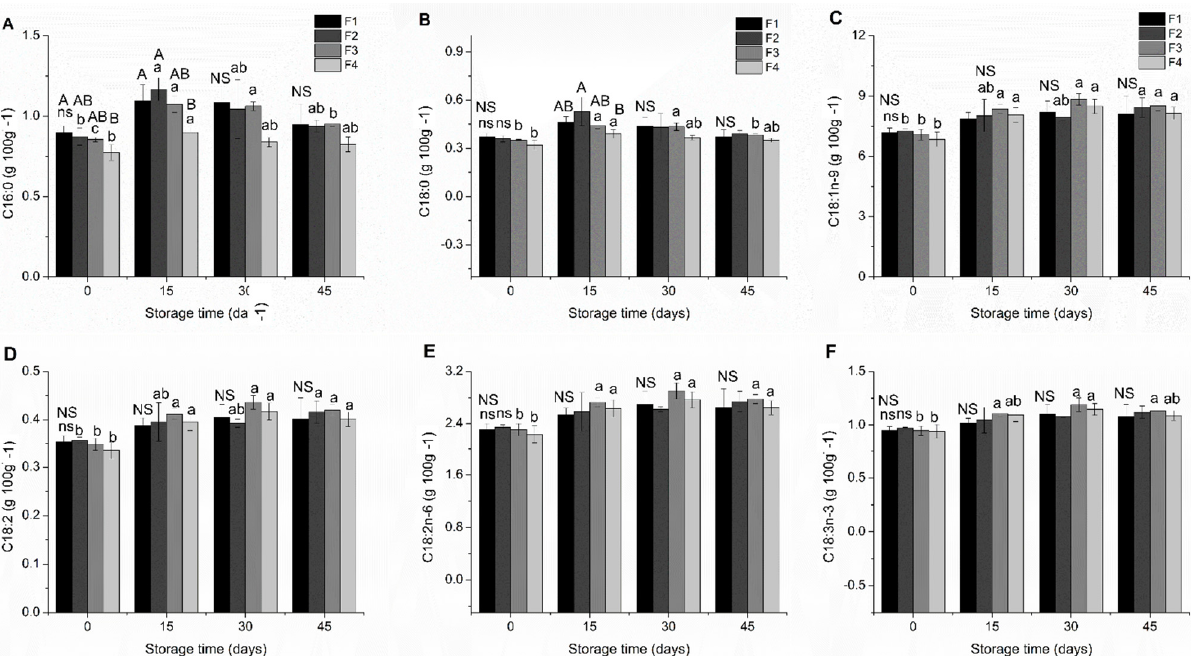
Figure 4. Fatty acids identified in starch biscuit formulation during storage time. ( A ) palmitic acid, ( B ) stearic acid, ( C ) oleic acid, ( D ): linoelaidic acid; ( E ) linoleic acid and ( F ) α -linolenic acid. F1: starch biscuit control (no added antioxidant); F2: starch biscuit added butylated hydroxytoluene (BHT); F3: starch biscuit added microencapsulated propolis co-product (MECP); F4: starch biscuit added lyophilized propolis co-product (LFCP). NS: there are no statistical differences ( p > 0.05) by the Tukey test between the formulations in the respective storage times. Different capital letters above a column of information represent statistical differences ( p < 0.05) by the Tukey test between the formulations in the respective storage times. Different lower-case letters above the column of the information column represent statistical differences ( p < 0.05) by the Tukey test for the formation during the storage